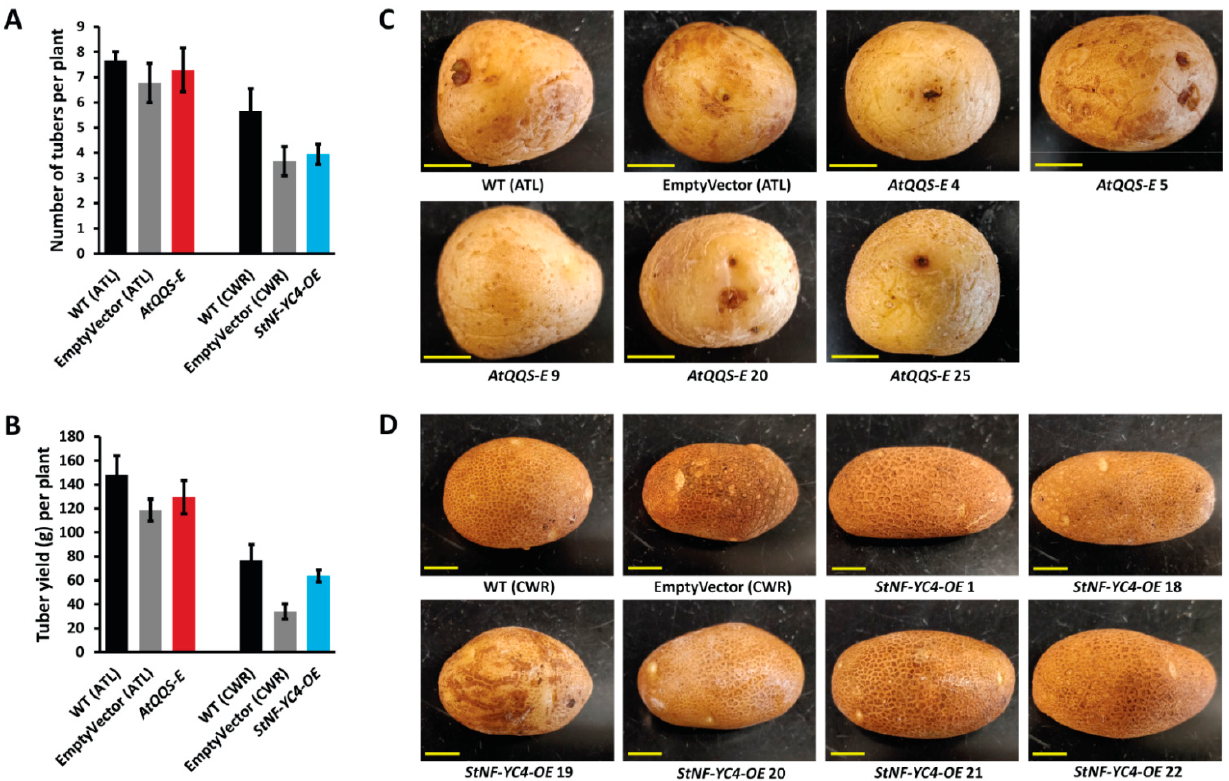
Figure 1. Tuber number, tuber yield, and tuber appearance were not impacted by AtQQS expression and StNF-YC4 overexpression. Number of potato tubers ( A ) and tuber yield ( B ) per plant, and the appearance of AtQQS-E ( C ) and StNF-YC4-OE ( D ) tubers. All tubers expressing AtQQS , WT (ATL), and EmptyVector (ATL) are of the Atlantic variety, and tubers overexpressing StNF-YC4 , WT (CWR), and EmptyVector (CWR) are of the Clearwater variety. All data in the bar chart show mean ± SE (Standard Error), n = 3. Student’s t -test was used to compare AtQQS-E , StNF-YC4-OE , and corresponding WTs in ( A , B ). None of the changes in ( A , B ) were significant ( p > 0.05). AtQQS-E , StNF-YC4-OE tubers had similar sizes, shapes, and appearances to the corresponding WT tubers in ( C , D ). Scale bar in ( C , D ), 1 cm.